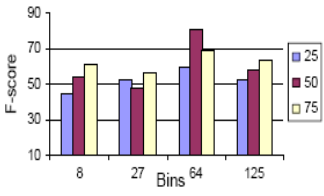
Fig. 7 Performance of the method by varying window